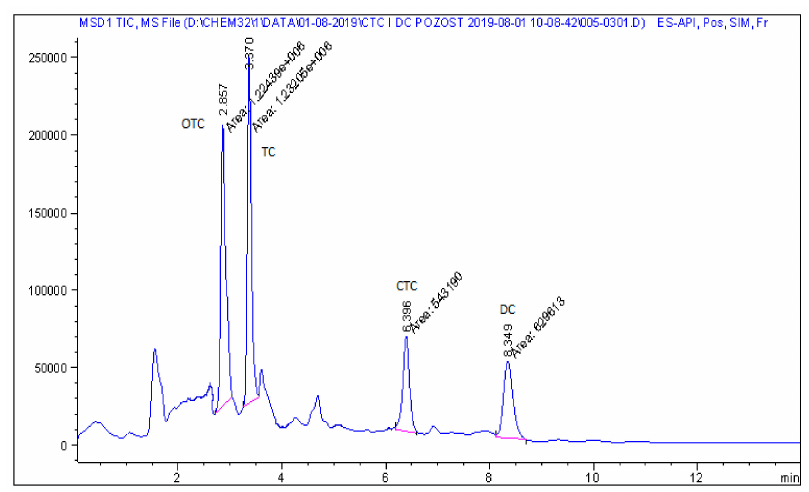
Figure 3. LC − MS chromatogram of a feed sample spiked with four tetracyclines at a concentration of 0.3 mg kg − 1 .